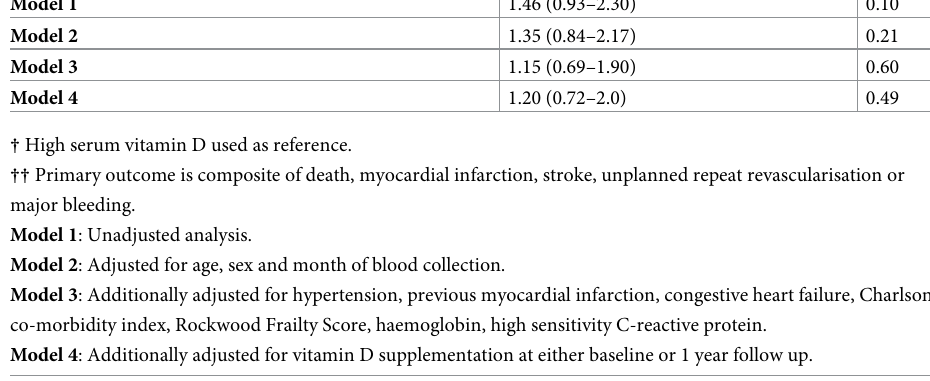
a low prevalence of vitamin D sufficiency, with a median value at baseline (29.5 nmol L -1 ) well below the international cut-off for vitamin D sufficiency (50 nmol L -1 ).